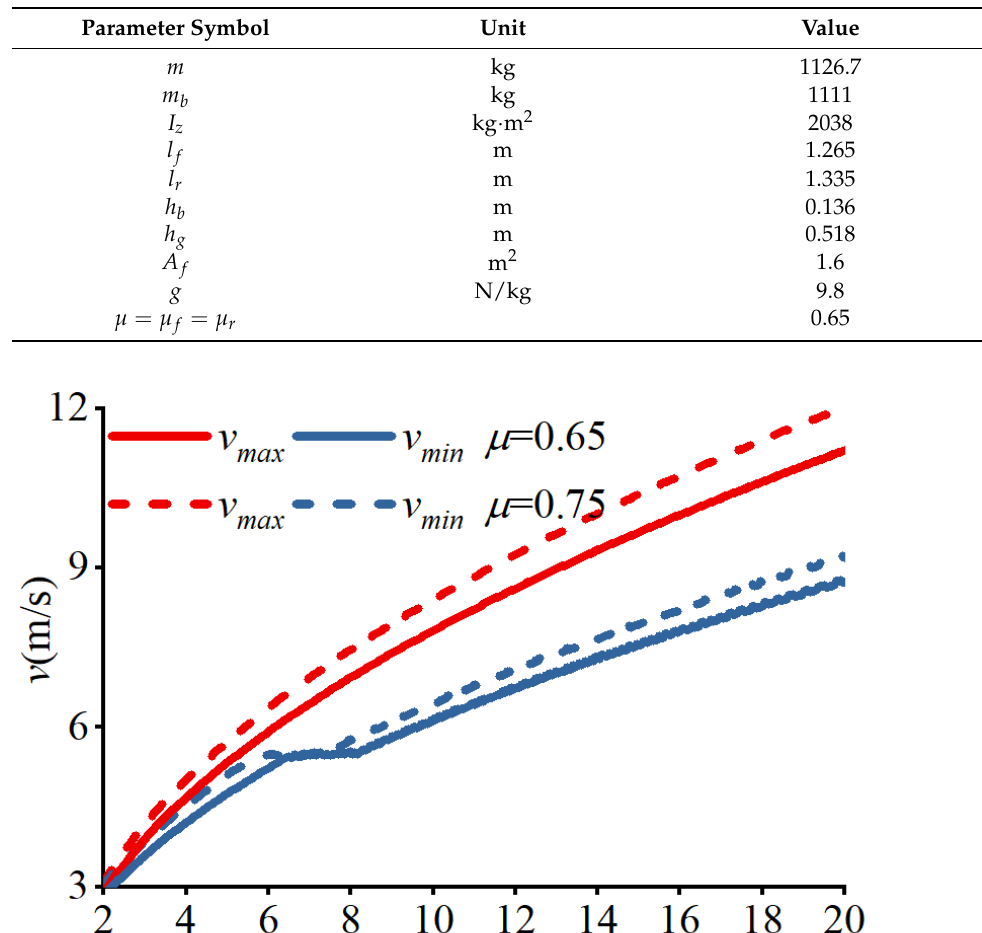
Table 1. The main parameters of the vehicle in simulations.